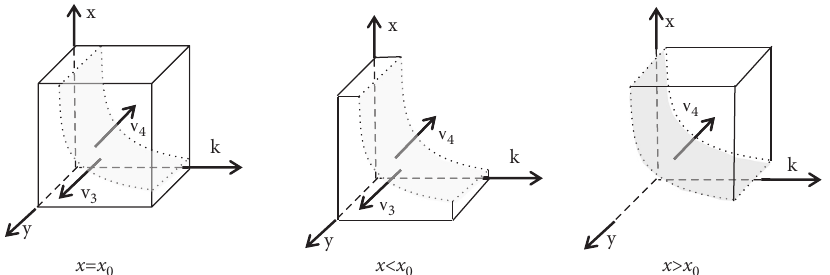
Figure 2: Phase diagram of banks’ strategy selection. (a) x � x